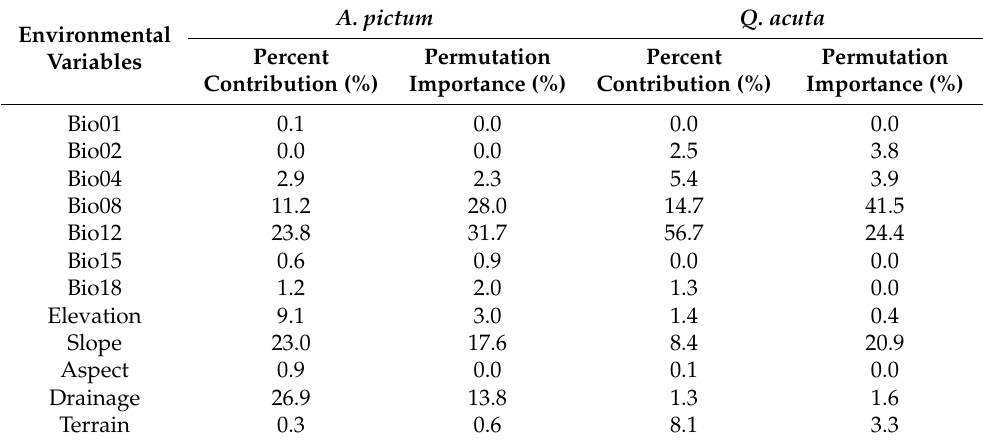
Table 2. Percent contribution and permutation importance of the environmental